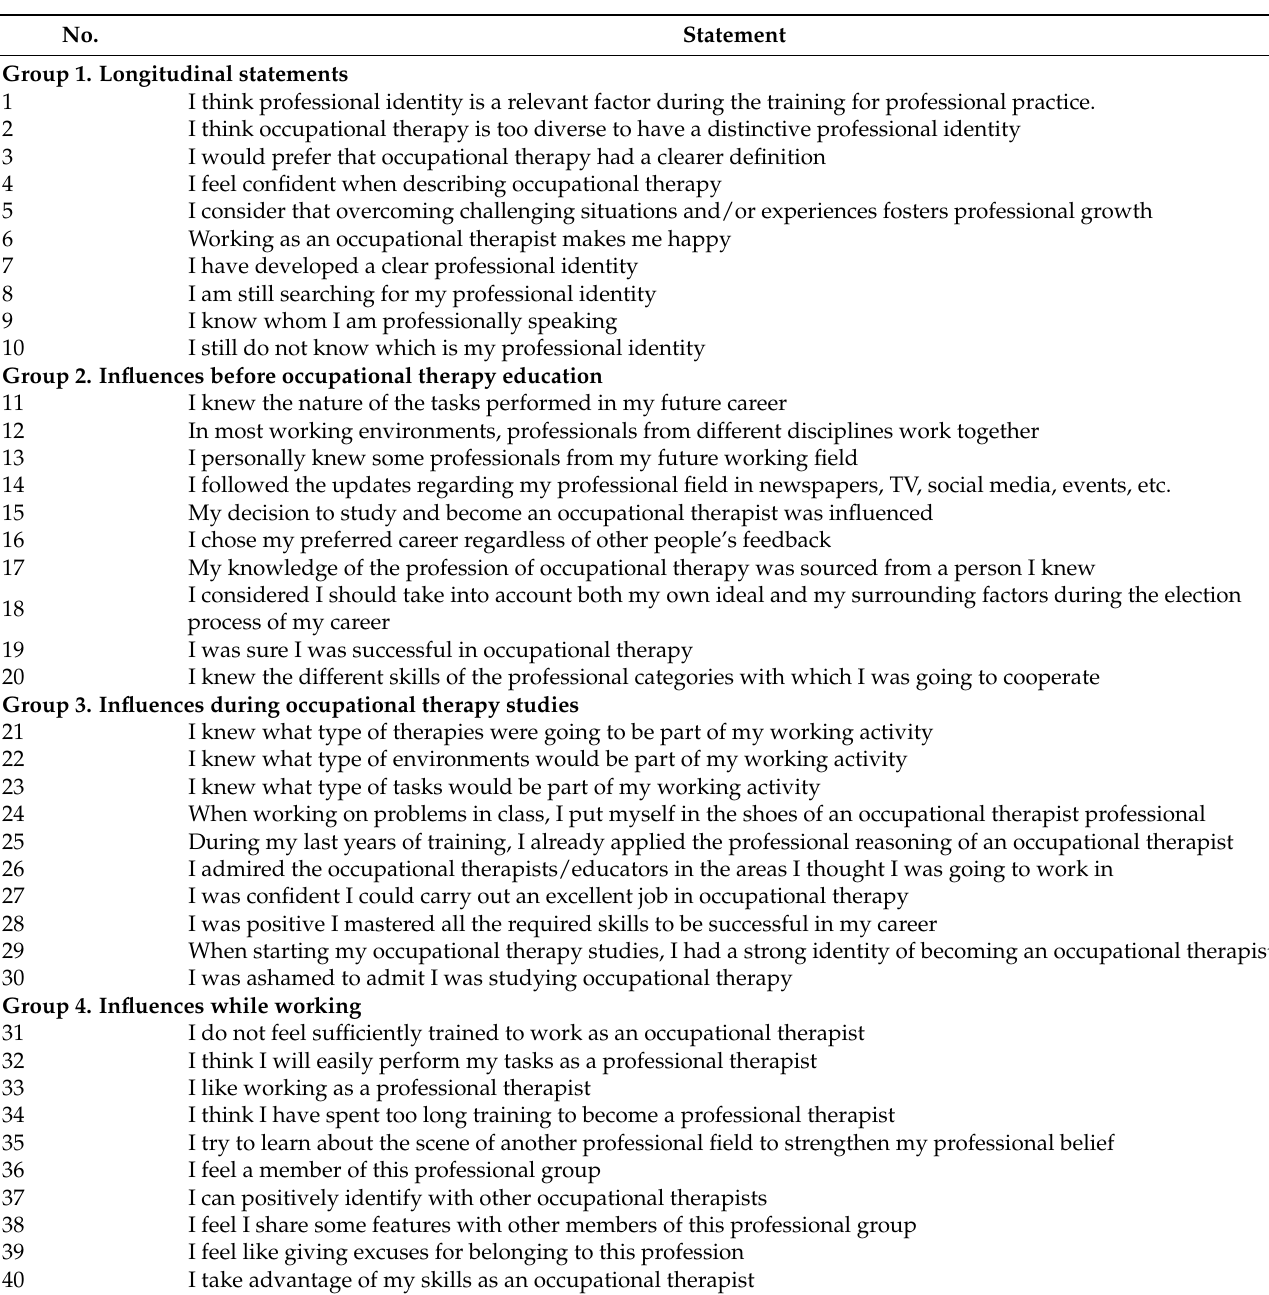
Table 1. Q sample statements prepared for